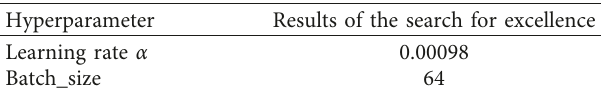
Table 2: Particle swarm algorithm optimization